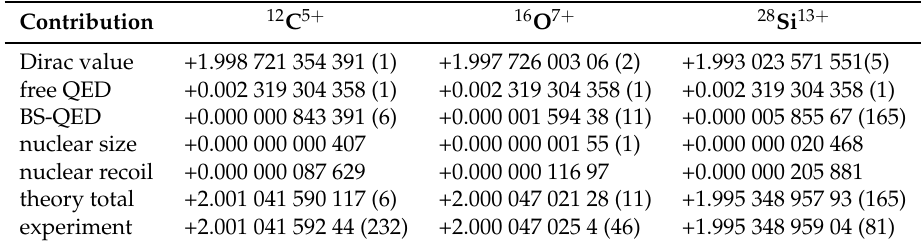
Figure 4. Illustration of the trap setup. ( Left ) Overview of the superconducting magnet setup with the Penning-trap located in the magnetic field center; ( Right ) Trap chamber with Penning-trap setup. Table 1. Calculated contributions to the g -factor of the electron bound in different hydrogen-like ions [31] and comparison to experimental values. The uncertainty in the theory reflects the estimates on the size of uncalculated higher-order terms. For comparison, the experimental results are listed. The uncertainties of the experimental values include the uncertainty of the electron mass at the time of the